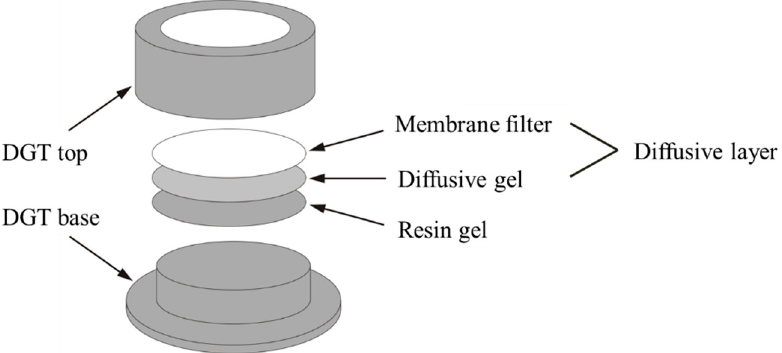
Figure 1. Component of a DGT device.